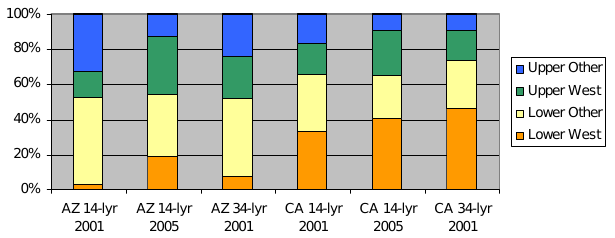
Fig. 11. Relative contributions of tracers to surface layer concentra- tions. “Upper” refers to tracers originating above 5400m; “lower” refers to tracers originating below 5400m. “West” includes only tracers on the western boundary of the domain. “Other” includes contributions from all other boundaries and initial concentrations. The fractions presented are based on monthly averages of tracer concentrations.